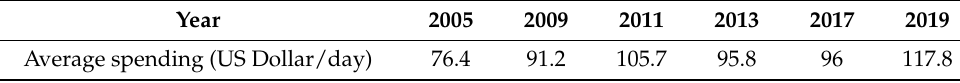
Table 2. Average spending per day of an international tourist in